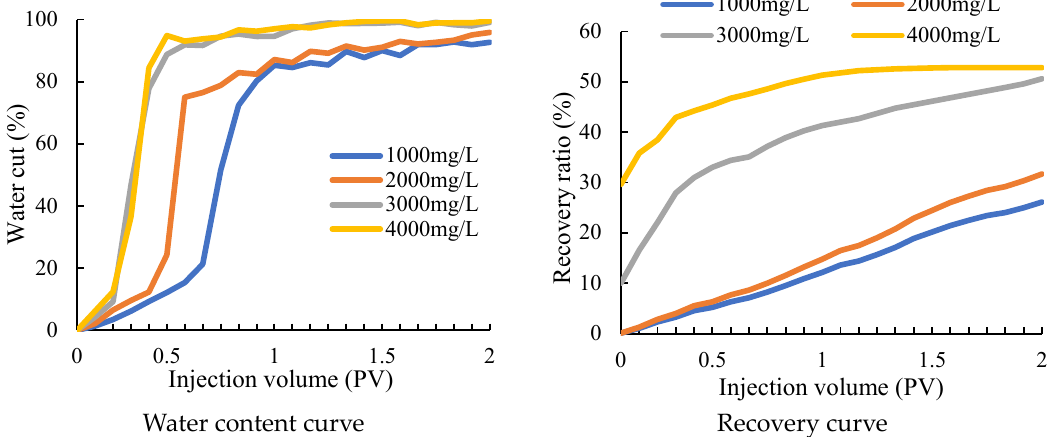
Figure 10. Variation curve of water cut and recovery factor under different concentrations.